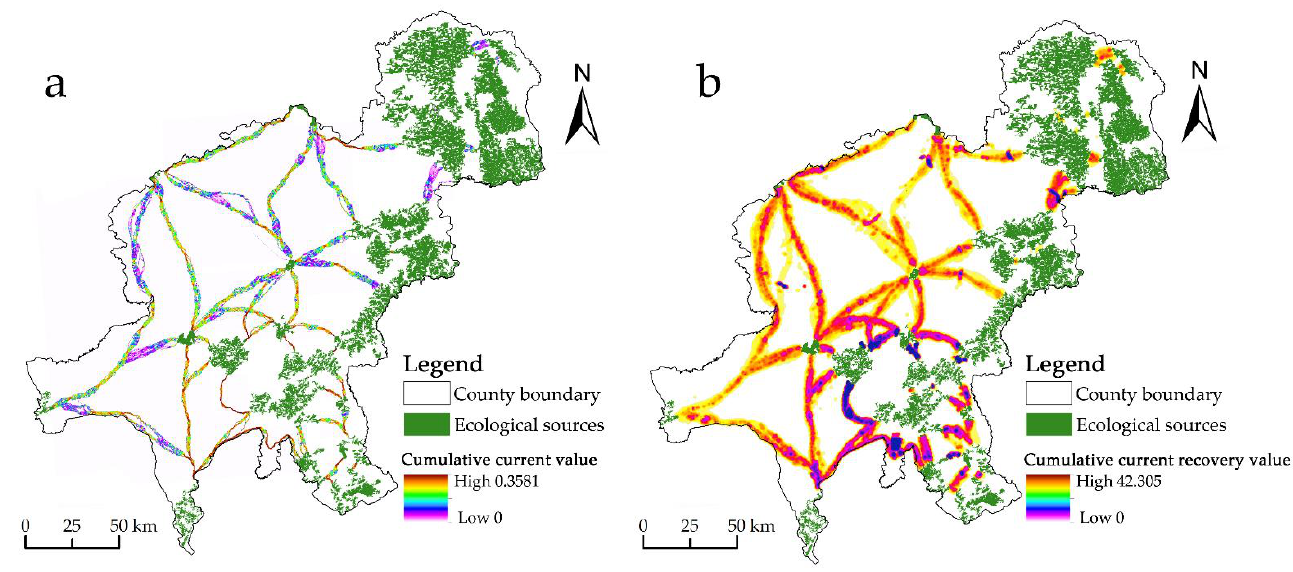
Figure 6. ( a ) Distribution of ecological pinch points. ( b ) Distribution of ecological barrier points.